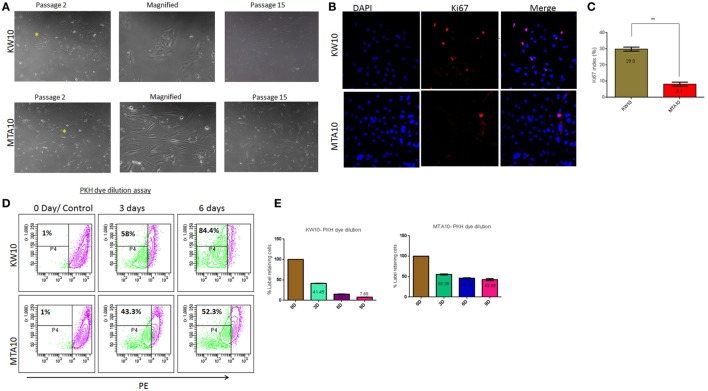
Establishment and phenotypic characterization of primary glioblastoma cell cultures—KW10 and MTA10. (A) Phase contrast micrographs of glioblastoma cells and at passage 15. (B) Ki67 staining. (C) Quantification of Ki67 expression (n = 3; **p < 0.001). (D) Quantification of cycling kinetics in a PKH dye dilution assay up to 6 days using flow cytometry. (E) Dye dilution quantified as mean ± SEM (n = 3; **p < 0.001).